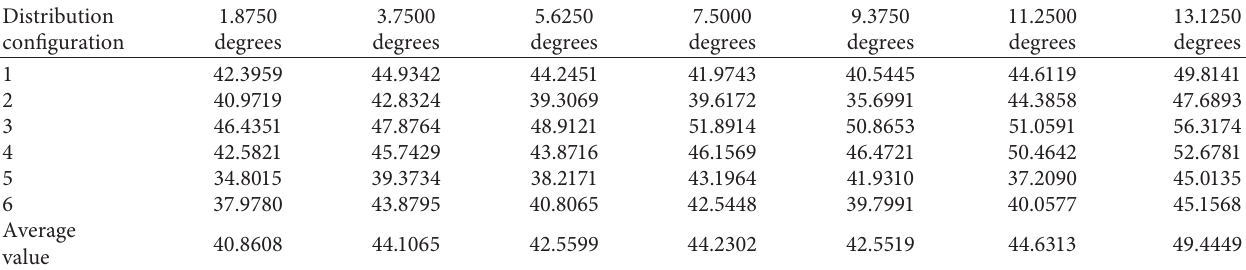
Table 3: Comparison of image relative error (%).